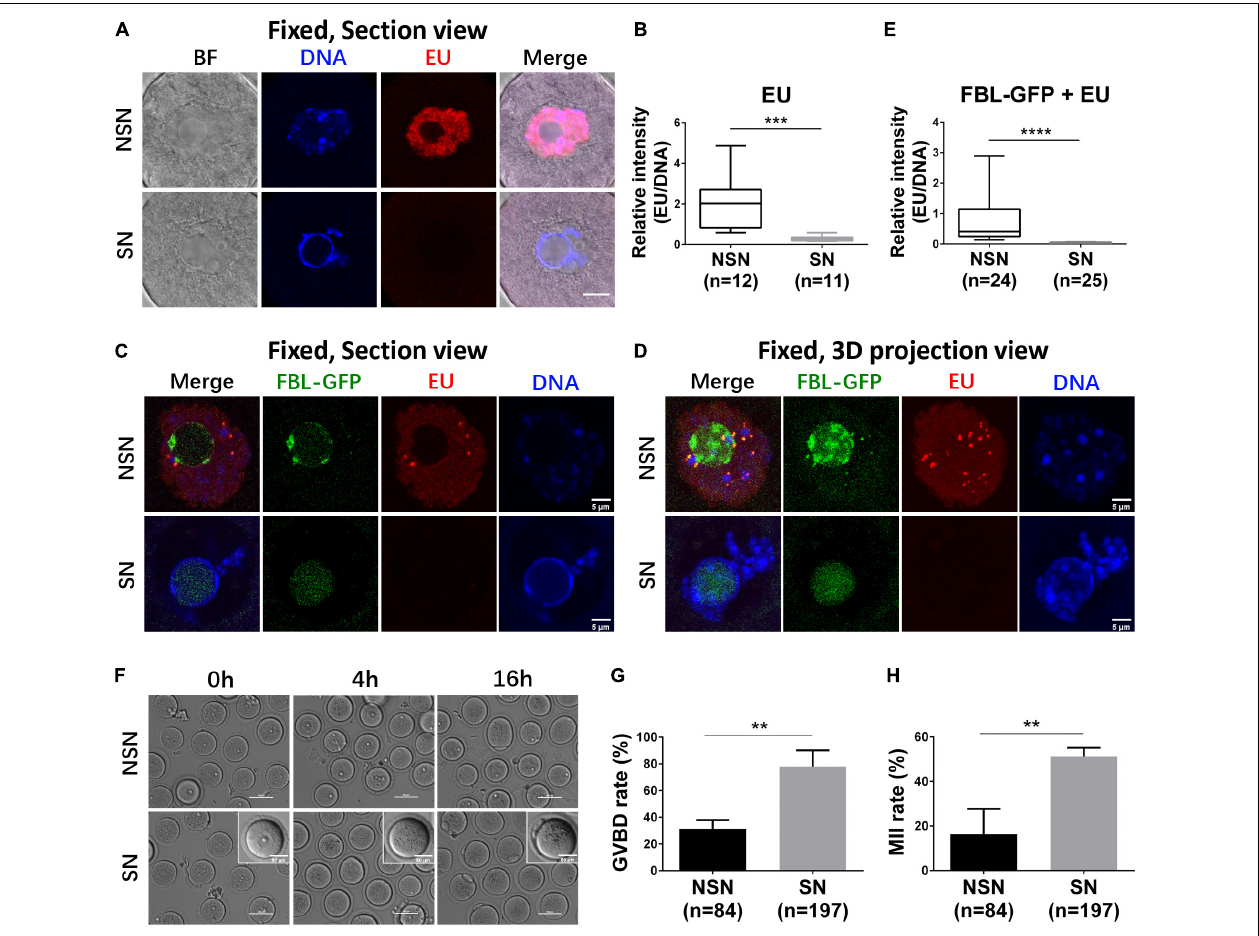
FIGURE 2 | The transcription activity of NSN and SN GV oocytes. (A,B) Representative z section images of nascent RNA transcription in NSN and SN GV oocytes. Box–whisker plot shows relative EU signal intensity to DNA signal intensity in NSN and SN GV oocytes. Scale bar = 10 µ m. N = 23. *** P < 0.001. (C–E) Representative z section (C) and 3D projection (D) confocal images of nascent RNA transcription in FBL–GFP-classified NSN and SN GV oocytes. Box–whisker plot shows relative EU signal intensity to DNA signal intensity in FBL–GFP-classified NSN and SN GV oocytes. Scale bar = 5 µ m. N = 49. **** P < 0.0001.